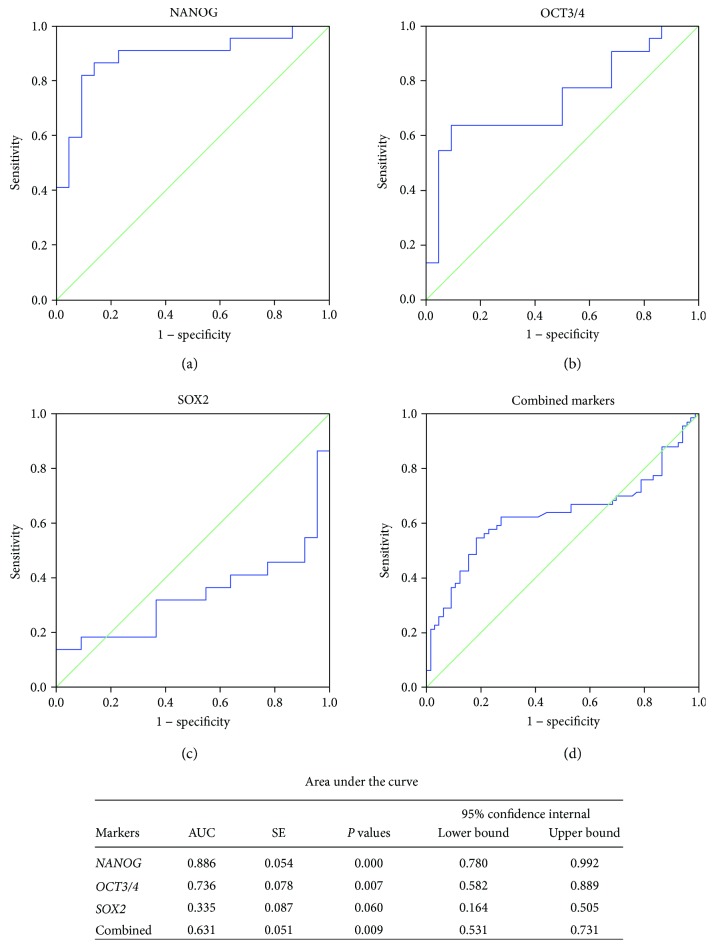
Diagnostic performance of pluripotent genes to discriminate between GBM and noncancer samples. NANOG and OCT3/4 showed high diagnostic values as biomarkers for GBM.